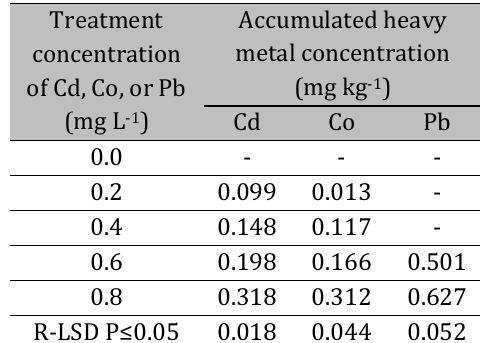
Table 2. In vitro accumulation of cadmium, cobalt, and lead in the root parts of the big- sage